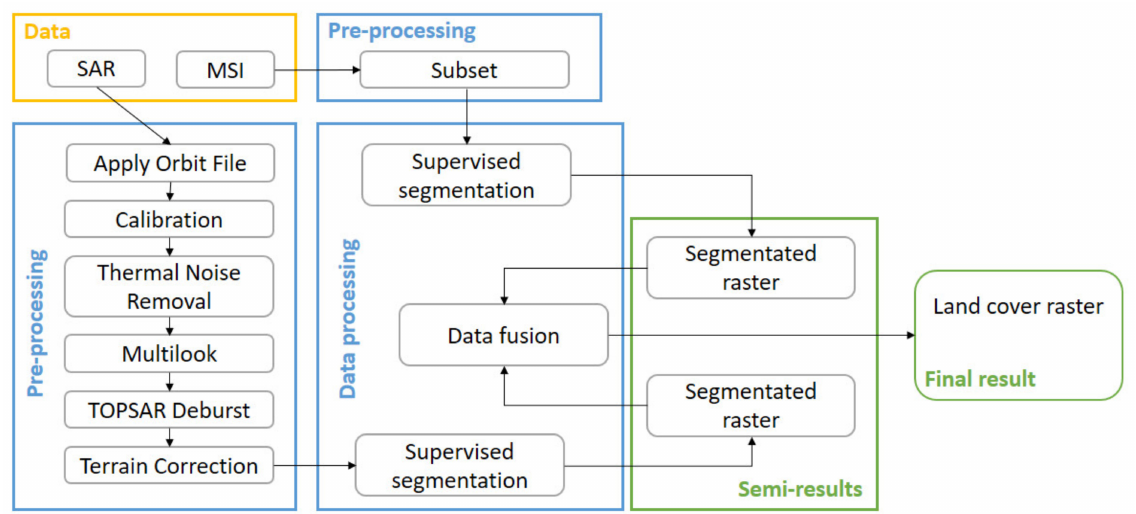
Figure 6. Processing schema of separate SAR and MSI segmentation methods.